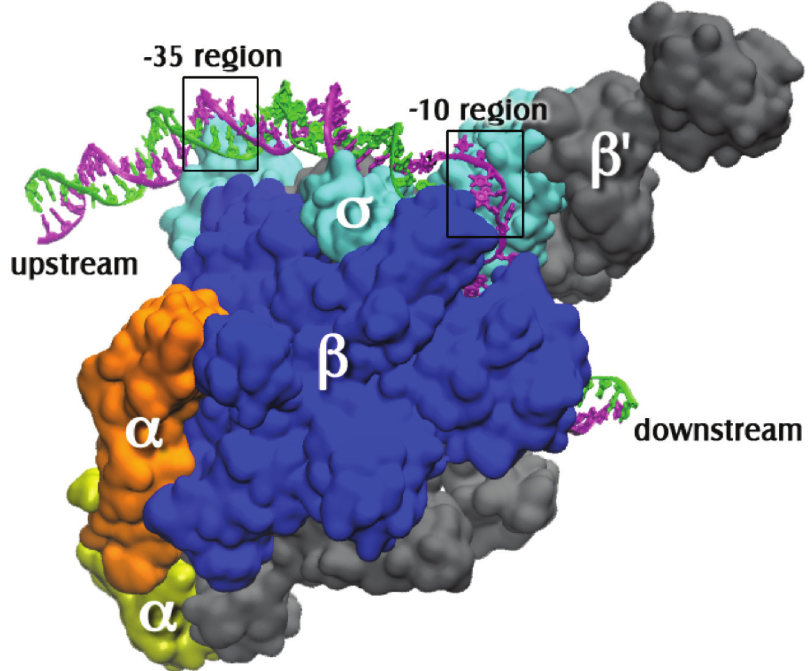
Figure 1. The open complex of RNA polymerase holoenzyme with promoter DNA. The coordinates for the protein and the DNA bases from (cid:3)12 to +12 of the nontemplate strand (magenta) and (cid:3)4 to +12 of the template strand (green) are from PDB X-ray crystal coordinates 4G7O from Thermus thermophilus open complex as reported by Zhang et al. [8]. The sigma subunit is (cid:2) A . Additional upstream and downstream DNA coordinates were modeled using the electron microscopy coordinates from PDB entry 3IYD [9]. The holoenzyme subunits are labeled and the precise locations of the (cid:3)10 (on the nontemplate strand) and the (cid:3)35 (on ds promoter DNA) regions are indicated by